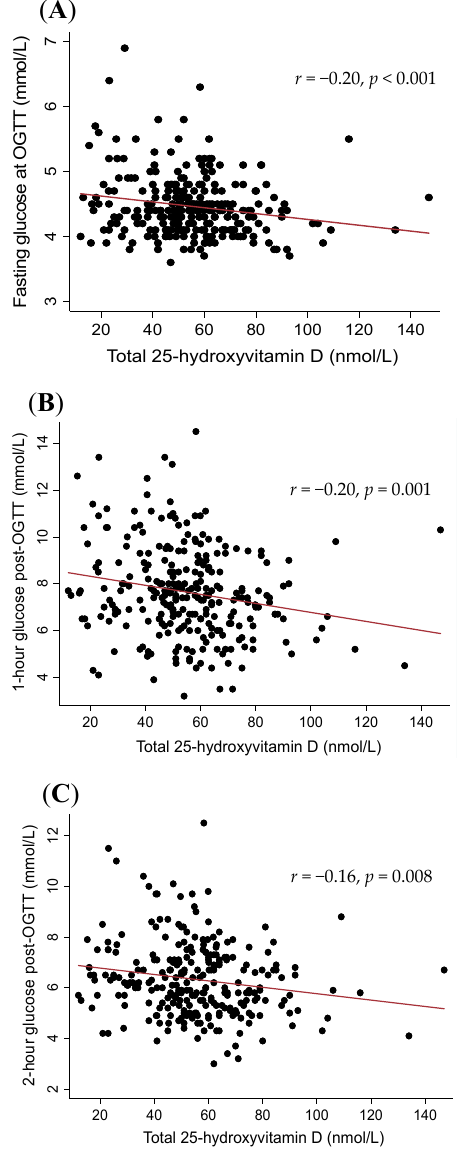
Figure 2. Scatterplots illustrating the correlations between total 25(OH)D with fasting glucose ( A ); 1 h glucose ( B ) and 2 h glucose ( C ) post-oral glucose tolerance test (OGTT).